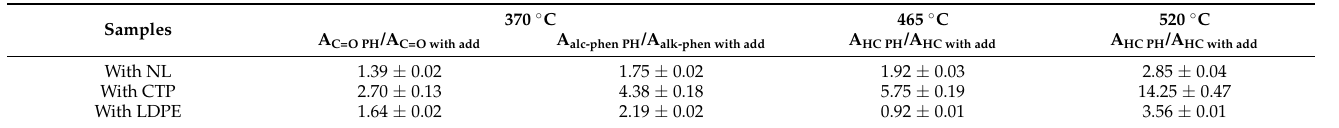
Table 5. The surface area ratios of the bands in the FT–IR spectra of volatile products of pyrolysis of PH sample and its blends with additives.